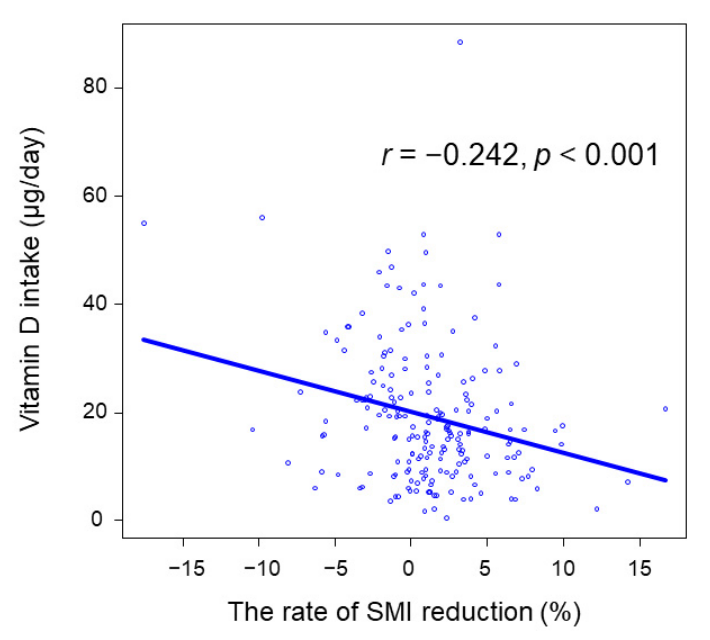
tigated in Figure 3. Vitamin D intake was correlated with the rate of SMI reduction